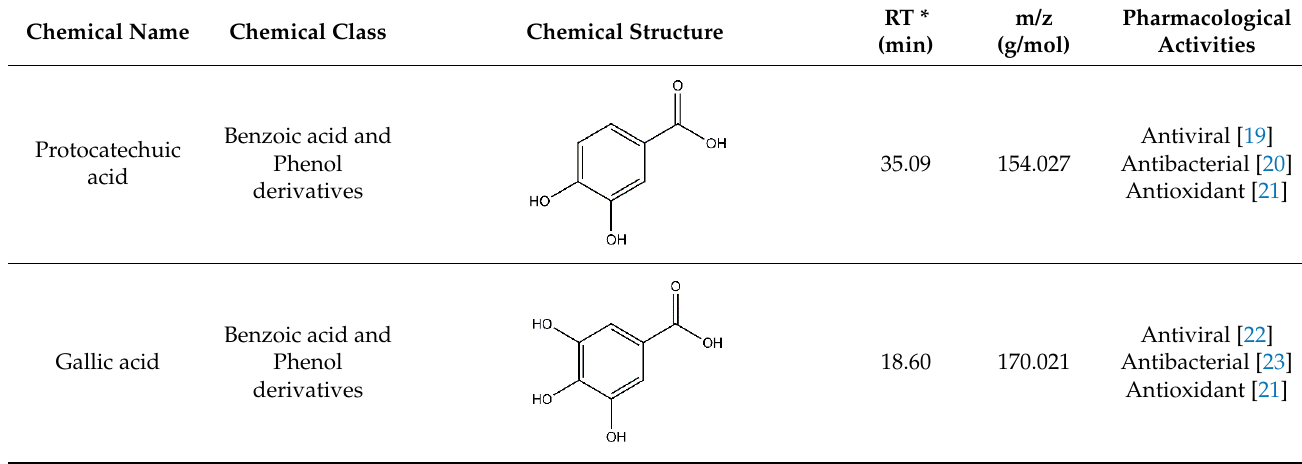
Table 5. Chemical compounds identified from walnut pellicle extract through UPLC-Ms/Ms [18] and related pharmacological activities.